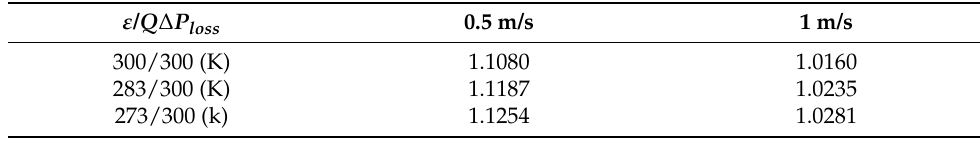
Table 2. Energy dissipation rate in different cases.